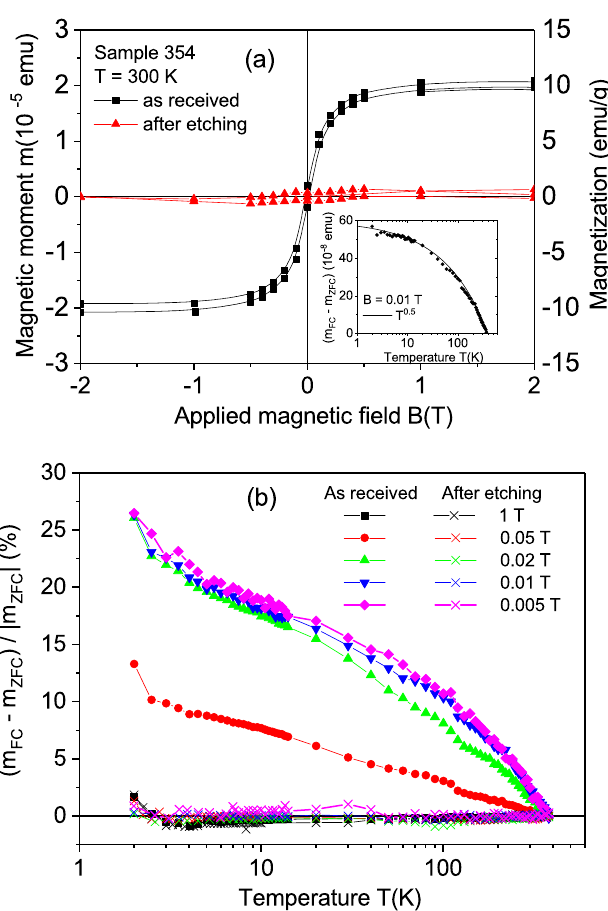
Figure 3. ( a ) Field hysteresis loops at 300 K of sample 354 in the as-received state and after chemical etching. The same linear diamagnetic background was subtracted from the measured curves. The inset shows the temperature dependence of the difference in the magnetic moment measured in the field-cooled (FC) and zero-field-cooled (ZFC) states measured at a fixed field of 0.01 T. The continuous line follows the equation m F C ( T ) − m Z FC ( T ) = 10 − 8 ( 60 − 3 T 0.5 ) (emu). ( b ) Temperature dependence of the relative difference 100 [ m F C ( T ) − m Z FC ( T )] / | m Z FC ( T ) | before and after